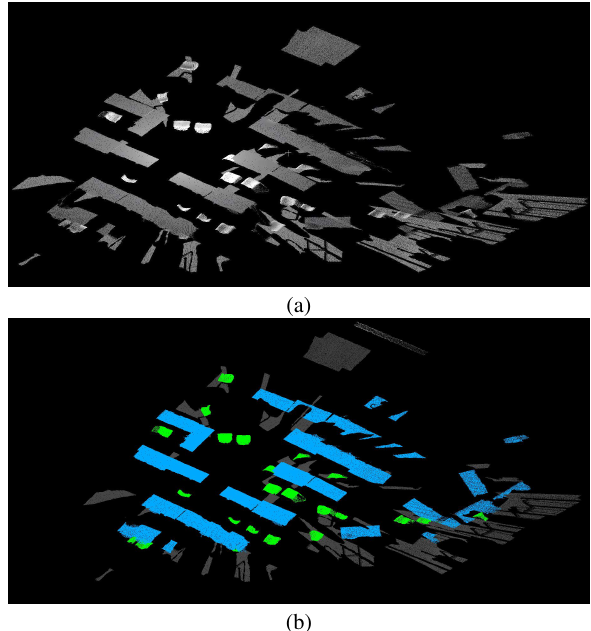
Figure 3: Point cloud of a classroom. (a) Horizontal planes. (b) Classification: Desks are coloured blue, chairs are green. They are identified by the height (Z-value) of the horizontal segments only.